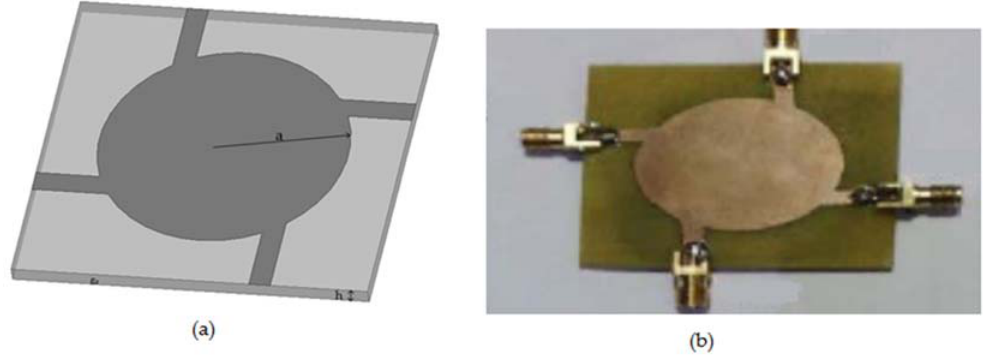
Figure 2. Circular Patch Crossover(CPC). (a) Schematic of CPC; ( b ) Photo of the fabricated prototype.